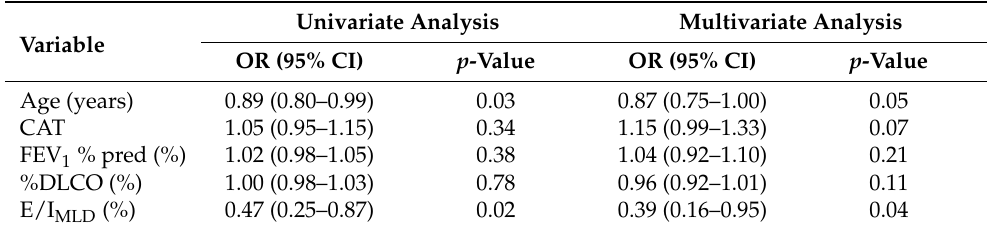
Table 4. Univariate and multivariate analyses of factors predicting sedentary behavior in patients with